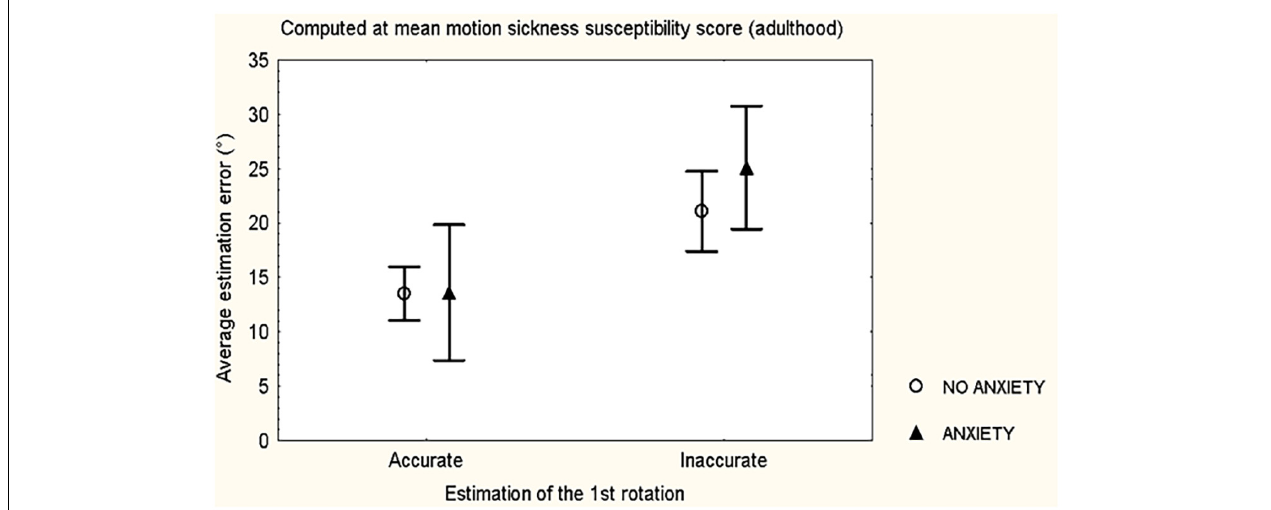
FIGURE 1 | Mean and standard error of the mean of the average estimation error during the updating orientation test, according to accuracy/inaccuracy of the estimation of the first rotation and evidence of Anxiety/No anxiety (HADS anxiety sub-score ≥ 8), of 81 healthy